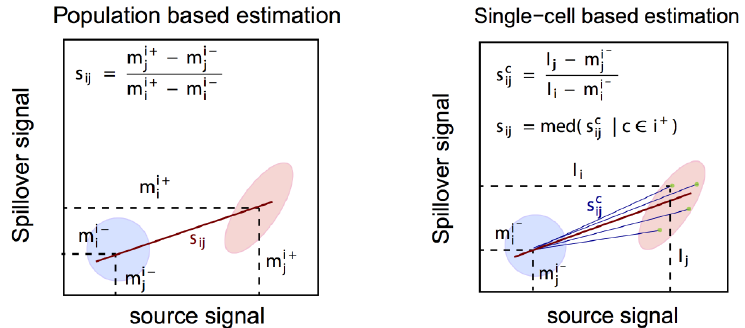
Figure 20. Population versus single-cell based spillover estimation. In a population-based setting (left), spillover is estimated as the slope of a line through the centers of positive (red) and negative (blue) populations. In a single- cell based setting (right), slopes are computed independently for each cell in the positive population, and spillover is estimated as their